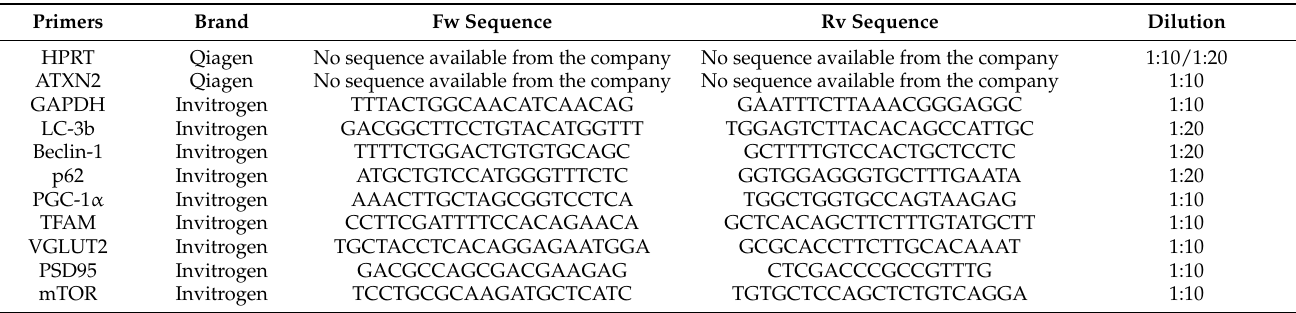
Table 2. RT-qPCRs primers